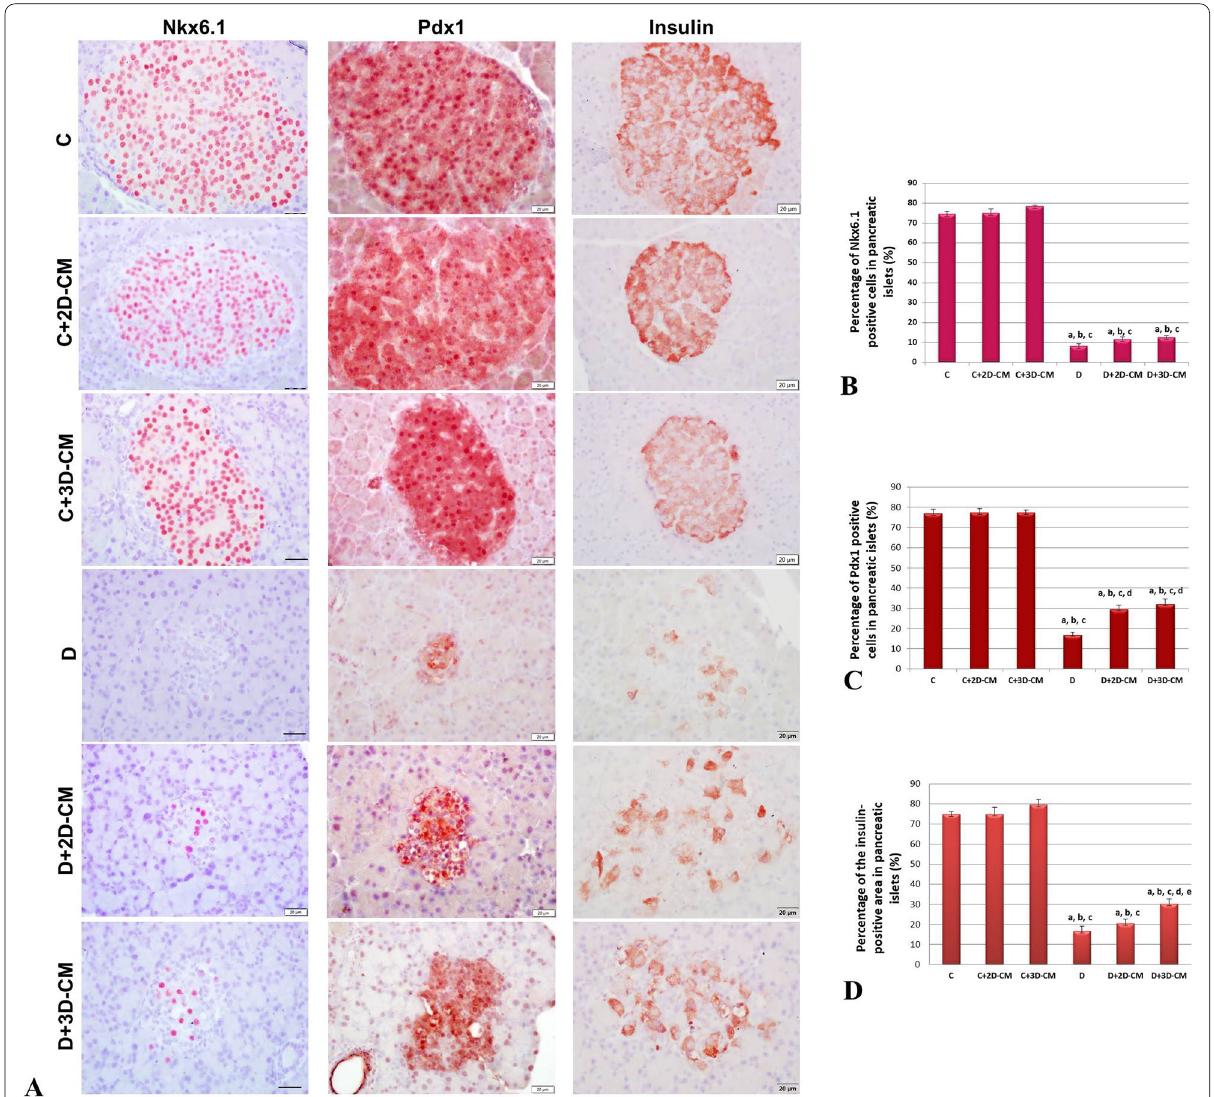
Fig. 6 Immunohistochemical analyzes. A Immunohistochemical analyzes showing numbers of the Nkx6.1, Pdx1‑positive, and insulin‑positive areas in the pancreatic islets, 40. B Percentage of the Nkx6.1‑positive cells in the islets. a p < 0.001 versus the C group, b p < 0.001 versus the C × group, c p < 0.001 according to the C 3D group. C Percentage of the Pdx1‑positive cells in the islets. a p < 0.001 versus the C group, b p < 0.001 versus + the C 2D‑CM group, c p < 0.001 versus the C 3D‑CM group, d p < 0.001 according to the D group. D Percentage of insulin positivity in the islets. a p + + < 0.001versus the C group, b p < 0.001 versus the C 2D‑CM group, c p < 0.001 versus the C + versus the D 2D‑CM group. Scale bar: 20 +